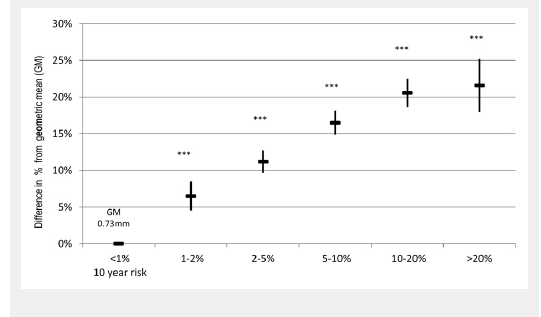
Association of AGLA-1 with aCIMT in SAPALDIA 3. ▬ Depicts estimated %difference of the geometric mean (GM), ▌ confidence interval of estimated %change. *** p-value <0.001, between risk and reference category, α adjusted for study area (random